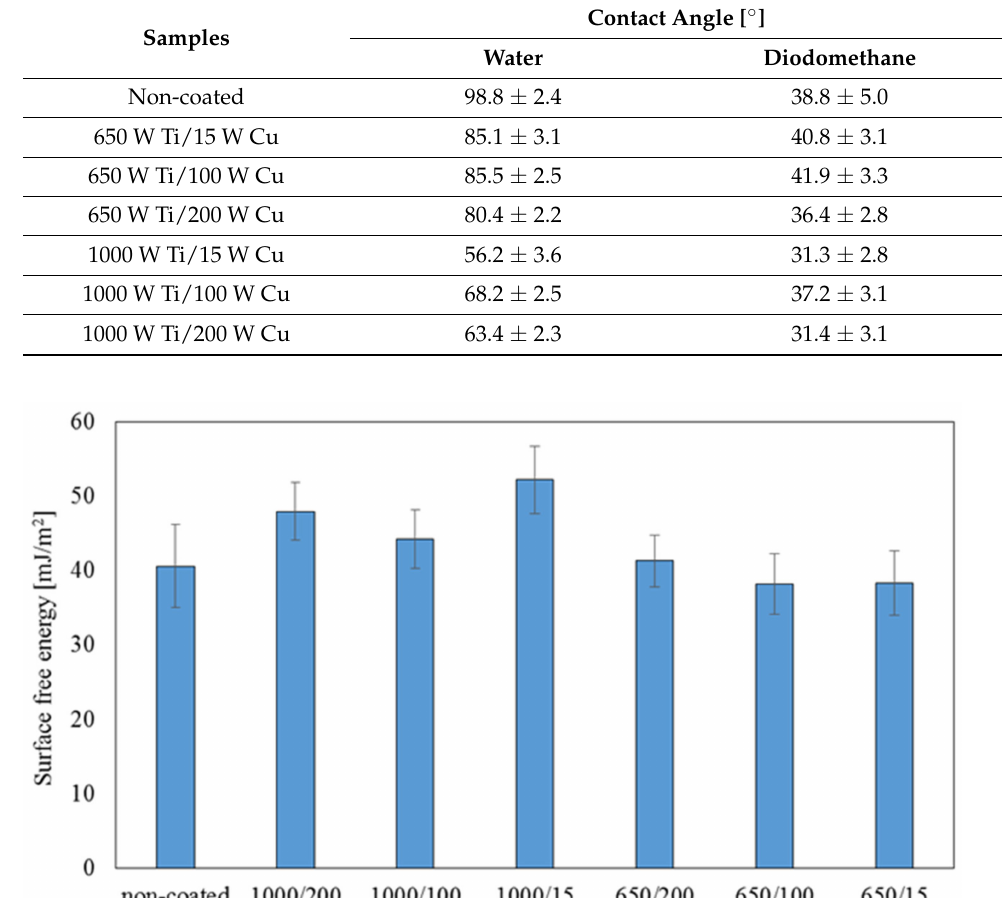
Table 2. Contact angles of the tested TiO 2 + CuO coatings.